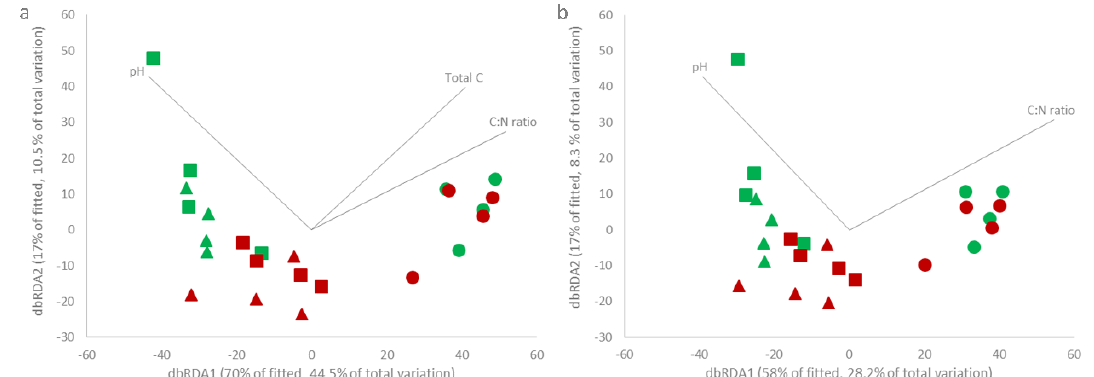
Figure 3. Distance-based redundancy analysis of the bacterial ( a ) and fungal ( b ) communities and rhizosphere soil chemical properties of the healthy and AOD trees across the sites ( n = 24). The soil parameters determined by BEST analysis are shown in each plot. The longer the line, the stronger the correlation between the microbiome composition and the soil chemistry. Eastnor—triangle; Hatchlands—square; Richmond—circle; healthy trees—green; AOD trees—red.